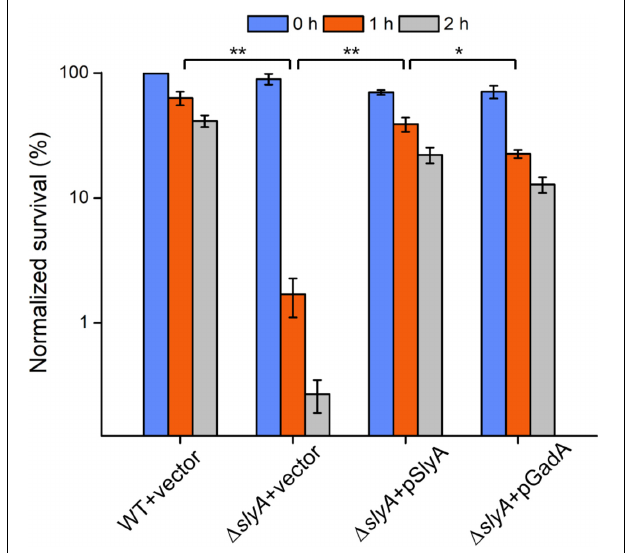
FIGURE 4 | Acid survival assays of various Shigella strains. Survival percentages of Shigella wild-type and (cid:49) slyA strains complemented with either empty vectors or SlyA/GadA-expressing plasmids were shown. Bacteria were incubated in acidic conditions for 0, 1, and 2 h and assayed for viability. Asterisks indicate significant differences ( ∗ p < 0.05 and ∗∗ p < 0.01).